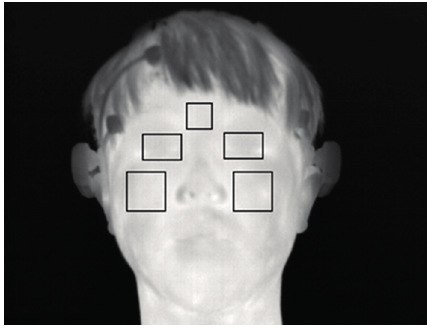
Figure 7. Example of defined ROIs used to measure the change of facial